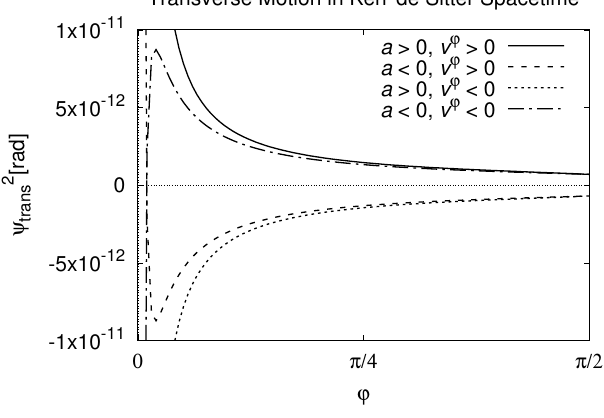
Figure 7. φ dependence of Equation